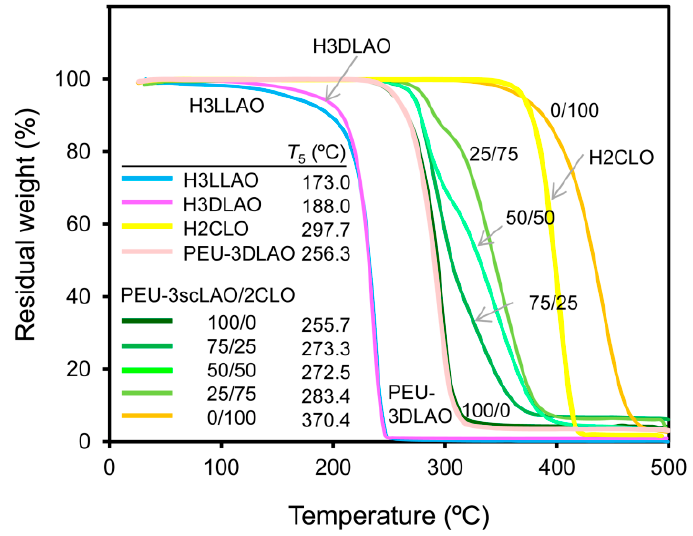
Figure 8. TGA curves of H3LLAO, H3DLAO, H2CLO, PEU-3DLAO and PEU-3scLAO/2CLOs (100/0, 75/25, 50/50, 25/75 and 0/100).